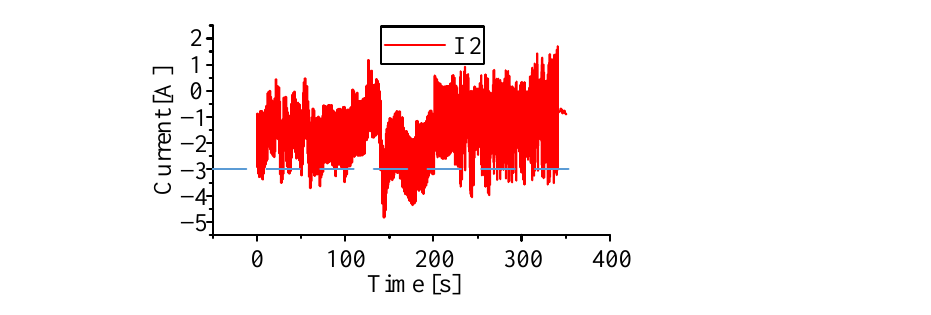
Figure 13. Lithium battery current change diagram, the blue dotted line represents the normal operating current range. (Adjacent equalisation circuits without equalisation strategy).